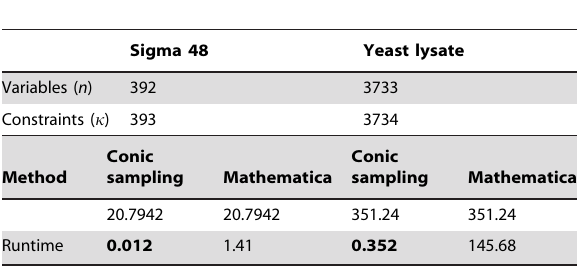
Table 1. QP runtimes from computational proteomics.